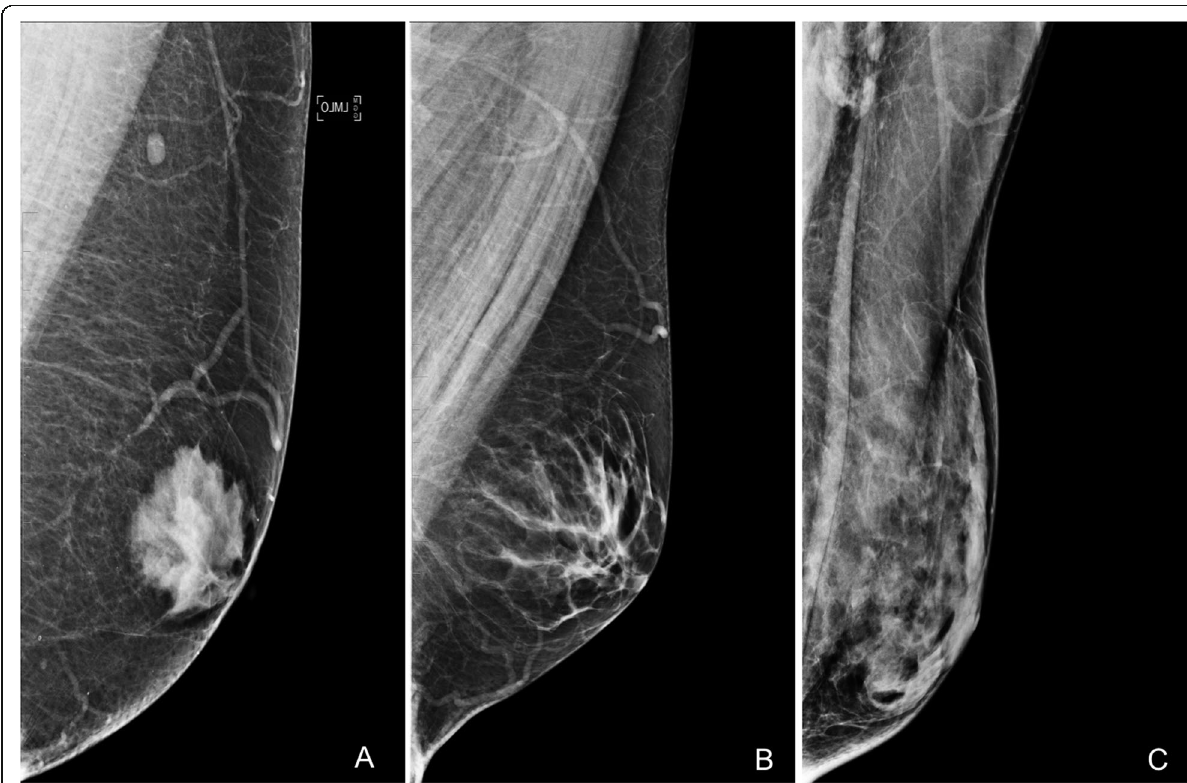
Fig. 30 Radiologic patterns in gynecomastia. a Nodular. b Dendritic. c